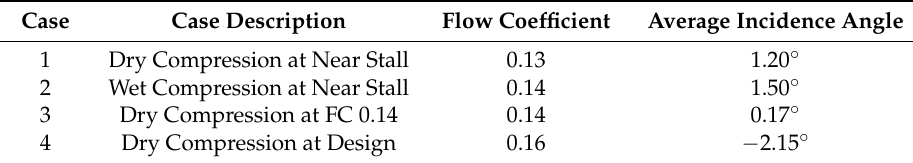
Table 2. The average incidence angle of dry and wet compression at diffuser